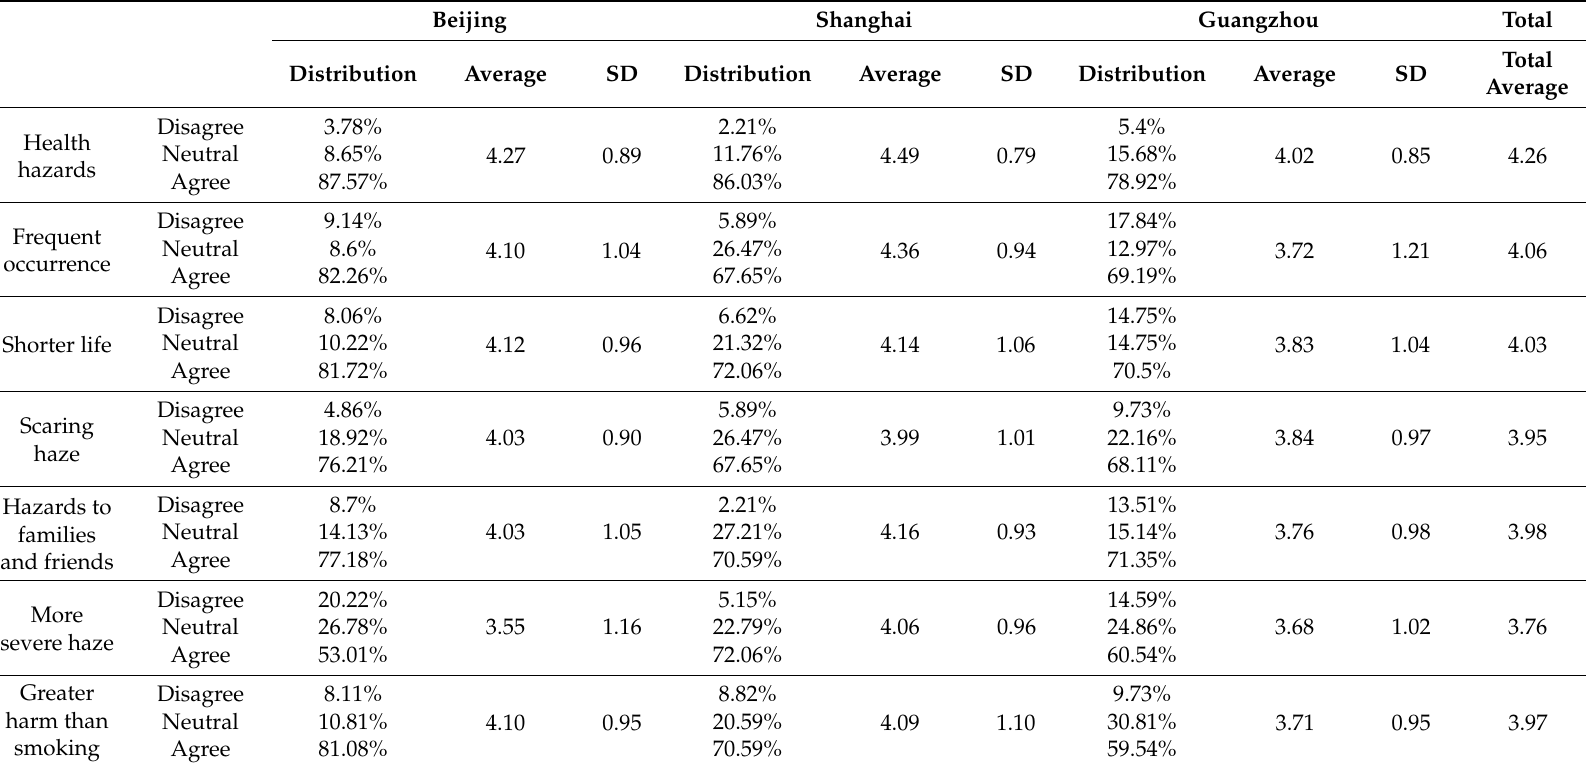
Table 7. Distribution of perceived risk in Beijing, Shanghai, and